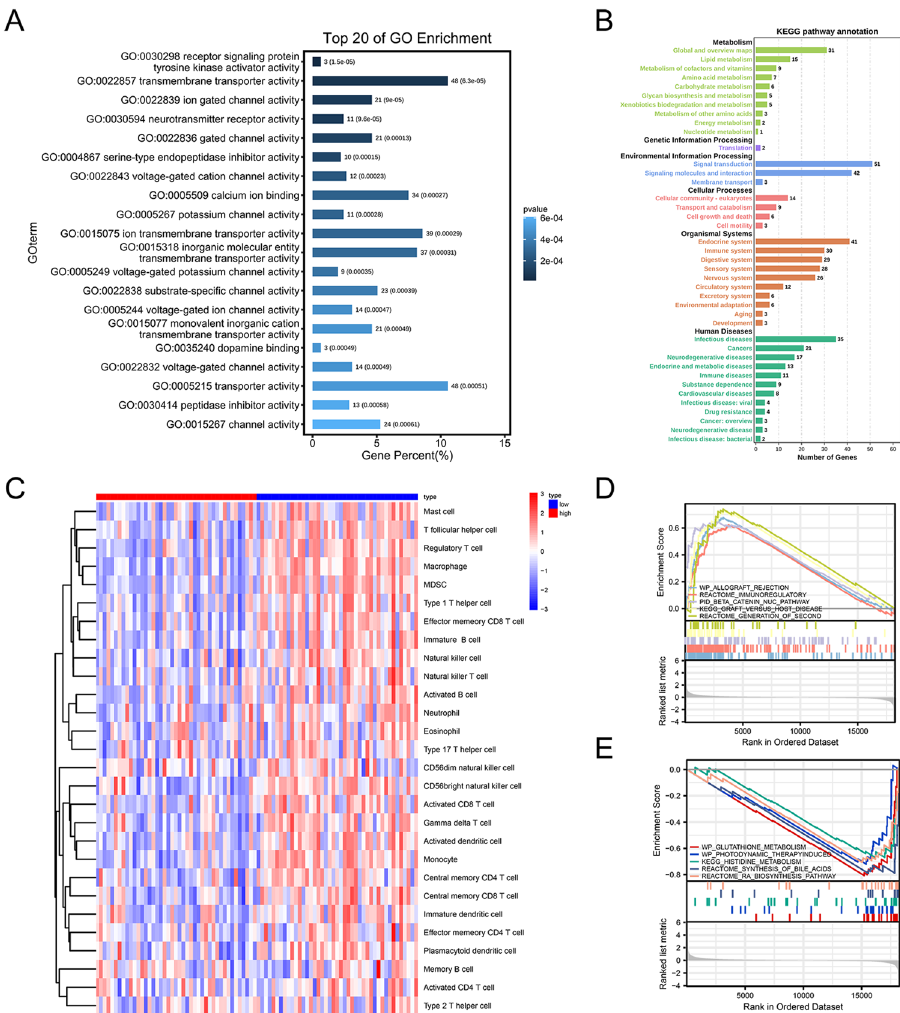
Figure 9. Functional enrichment of differentially expressed genes (DEGs) in the TARGET-OS cohort. ( A , B ) Gene Ontology (GO) and Kyoto Encyclopedia of Genes and Genomes (KEGG) enrichment analyses of DEGs in the high- and low-risk groups. ( C ) Enrichment analysis of immune gene sets by using single sample gene set enrichment analysis (ssGSEA) algorithm in the high- and low-risk groups. ( D , E ) The enrichment analysis in the high- and low-risk groups through Gene set variation analysis (GSVA) (pathways ranked among top 4 are presented in the